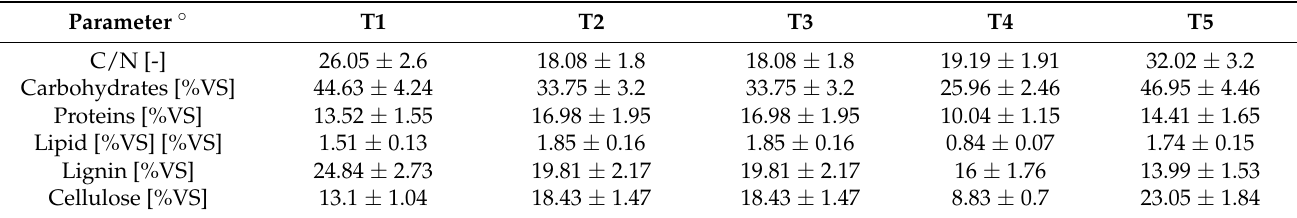
Table 1. Feedstock and inoculum